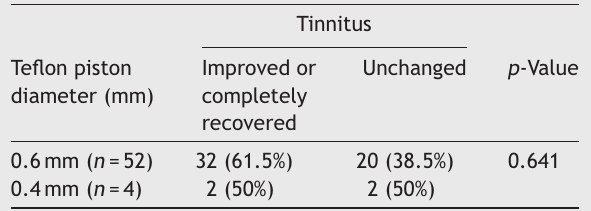
Relationship between Teflon piston diameter and tinnitus